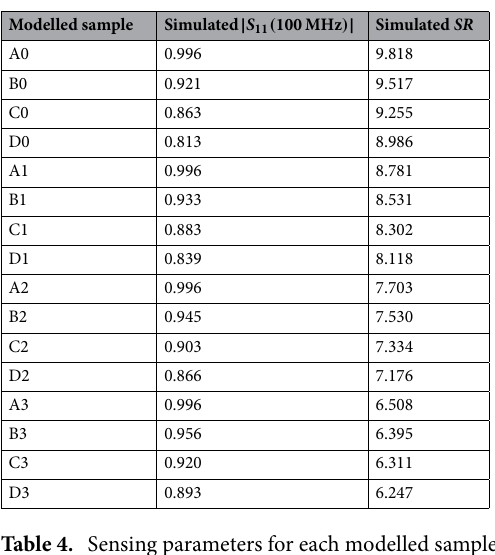
Table 4. Sensing parameters for each modelled sample, extracted from EM simulations.